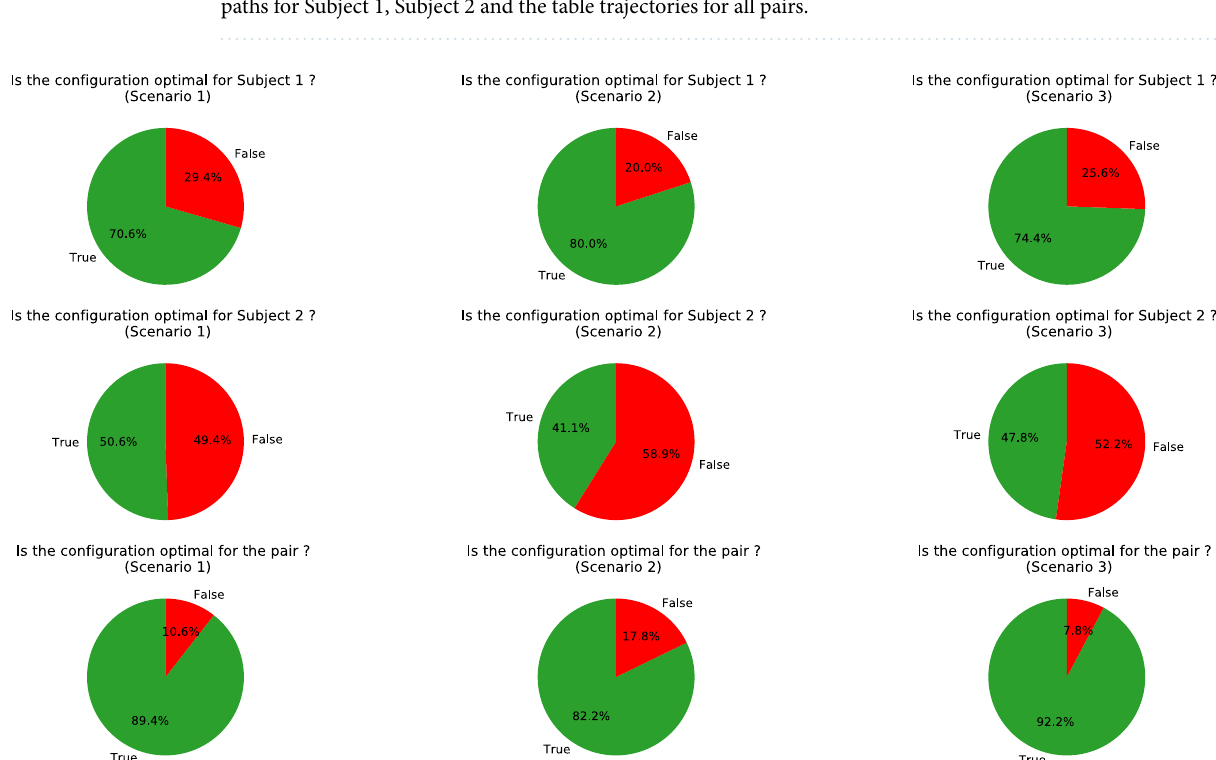
Figure 5. Boxplots of the linear (on the left) and angular (on the right) distances between forward and return paths for Subject 1, Subject 2 and the table trajectories for all pairs.